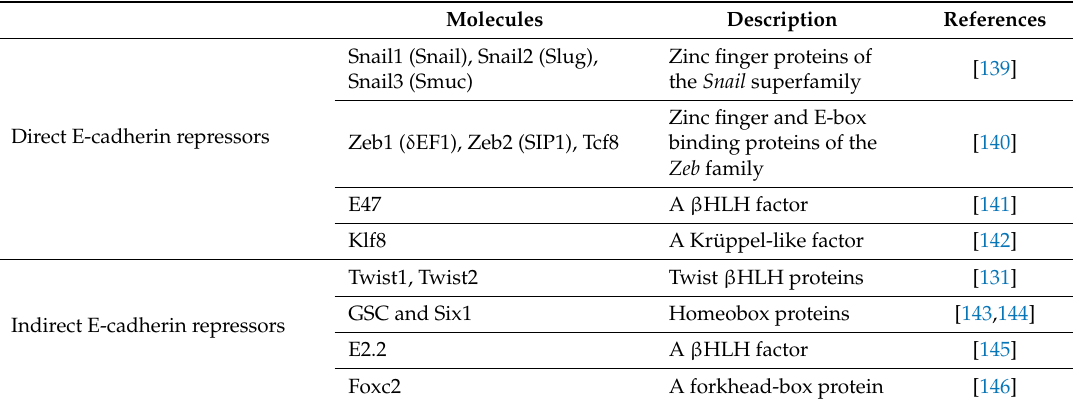
Table 2. List of EMT inducers that repress